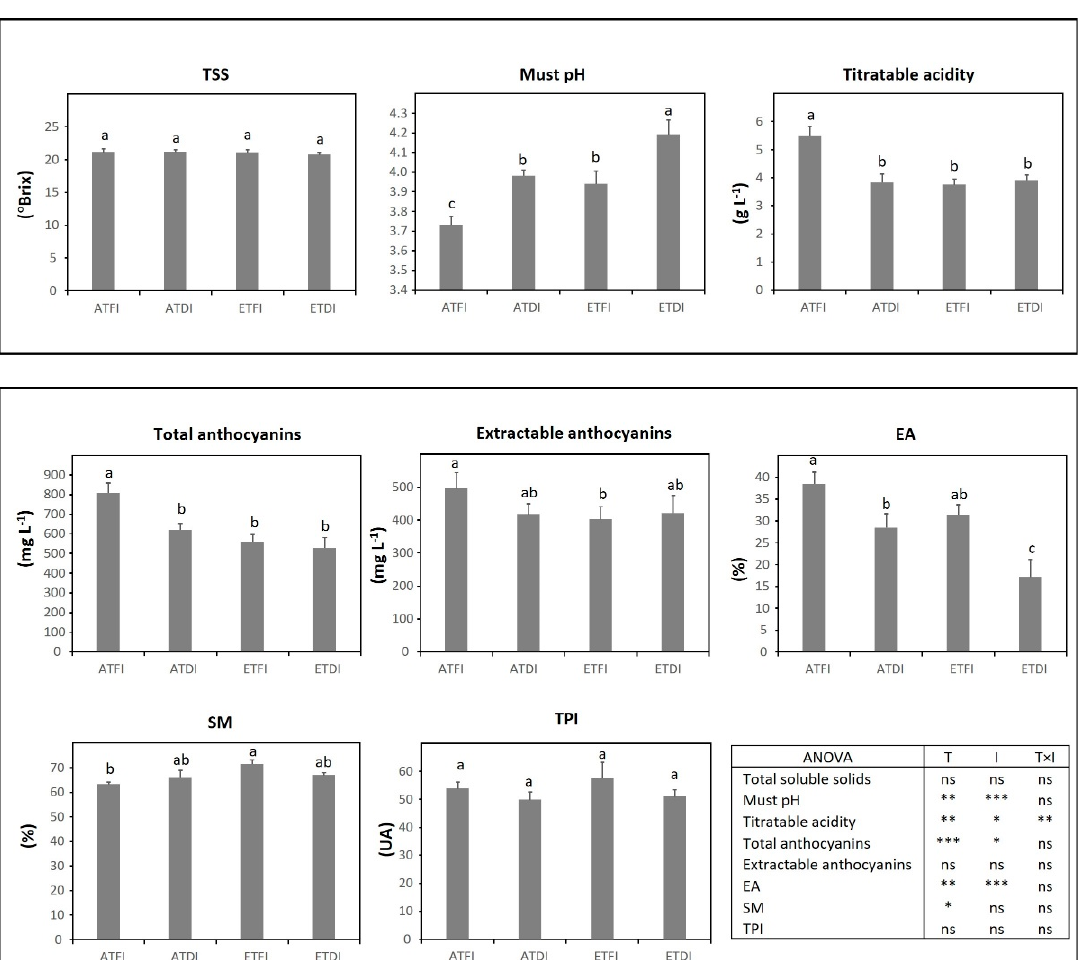
Figure 6. Grape technological and phenolic maturity assessed at harvest in fruit-bearing cuttings of Grand Noir (GNO) grown either at ambient (AT) or elevated temperature (ET) and subjected to different irrigation regimes (FI, full irrigation; DI, deficit irrigation). Values are means ± S.E. ( n = 5). Bars topped by the same letter do not differ significantly ( p > 0.05) according to Duncan’s test. Significance of the analysis of variance (ANOVA): * p < 0.05; ** p ≤ 0.01; *** p ≤ 0.001; ns, not significant ( p ≥ 0.05). TSS, total soluble solids; TPI, total polyphenol index; EA, cellular extractability of anthocyanins; SM, seed maturity; AU, absorbance units.